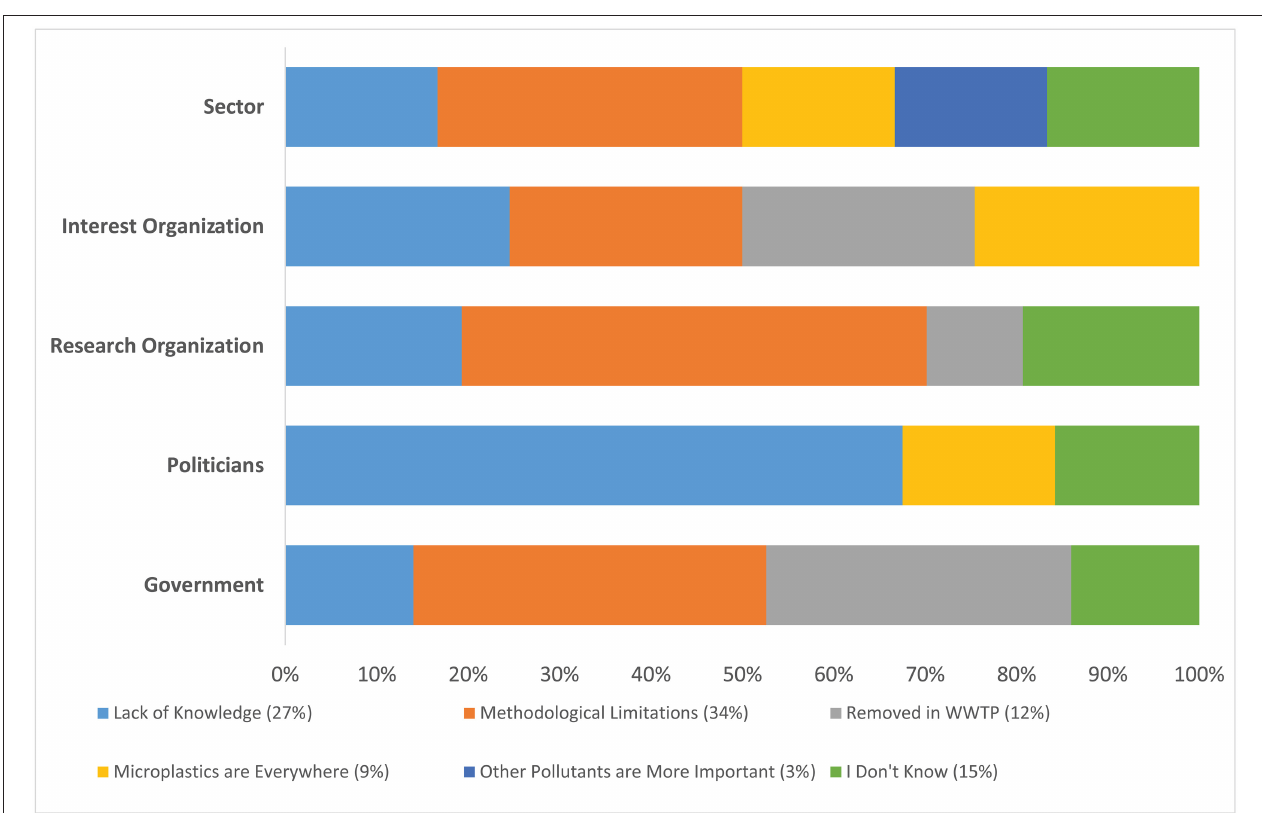
FIGURE 6 | “What is known about MPs in sludge?” By category of stakeholder. Percentages reported represent the frequency with which an issue was mentioned across all stakeholders responding ( n = 33).